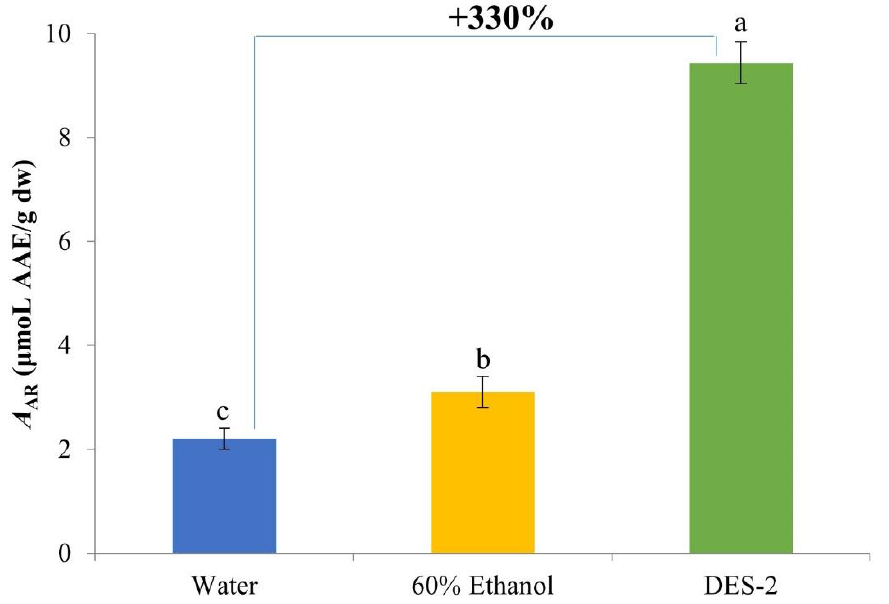
Figure 4. DPPH antioxidant activity ( A AR , µ moL AAE/g dw) of extracts from APW using various solvents and DES-2 obtained by the optimum extraction conditions; Standard deviation is presented with error bars and means with different superscript letters are significantly ( p < 0.05) different.